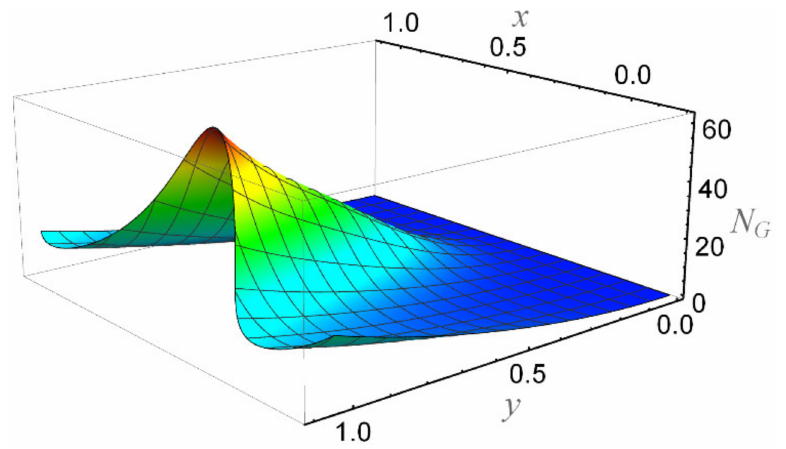
Figure 23. The entropy number when Br = 5, ε = 0.2, α = 0.3, We = 0.01, β = 0.1, K = 2, R n = 3, Ha = 1, n = 0.2, and Ec = 0.05.